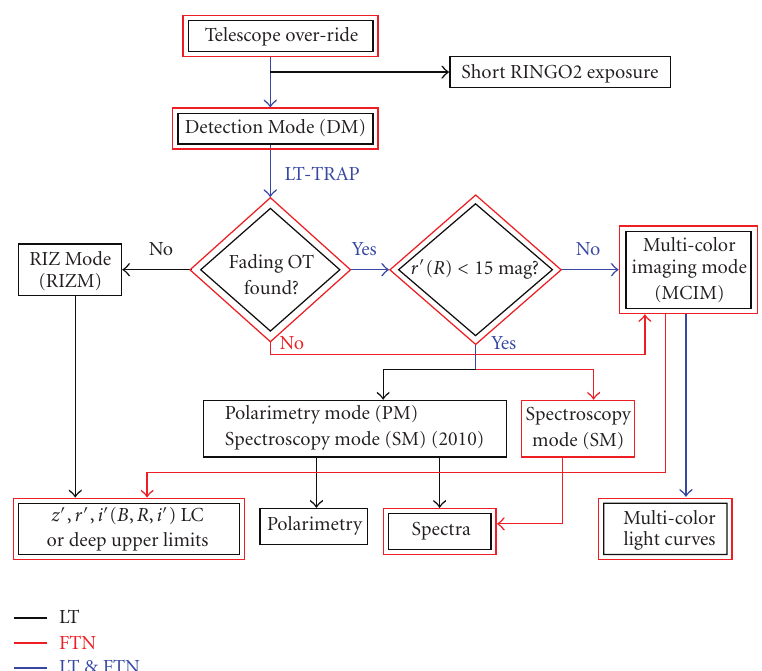
Figure 3: Flow chart of the robotic GRB pipeline currently running on the Liverpool and Faulkes Telescopes (adapted from